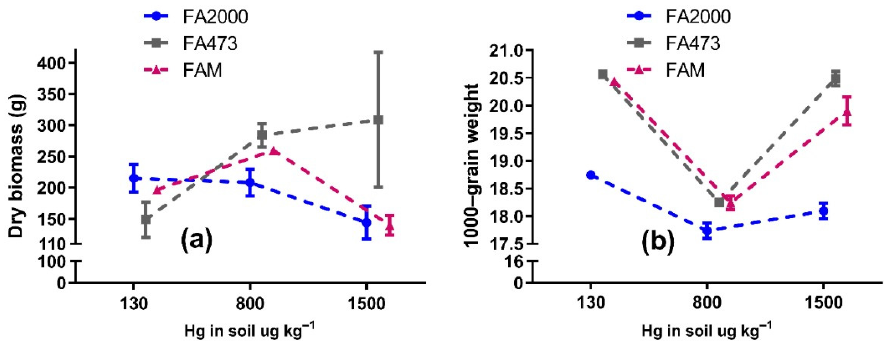
Figure 1. Dry biomass in grams per pot ( a ) and weight (g) per 1000 grains ( b ) of the commercial Oryza sativa L. varieties at different Hg levels in La Mojana region soil.